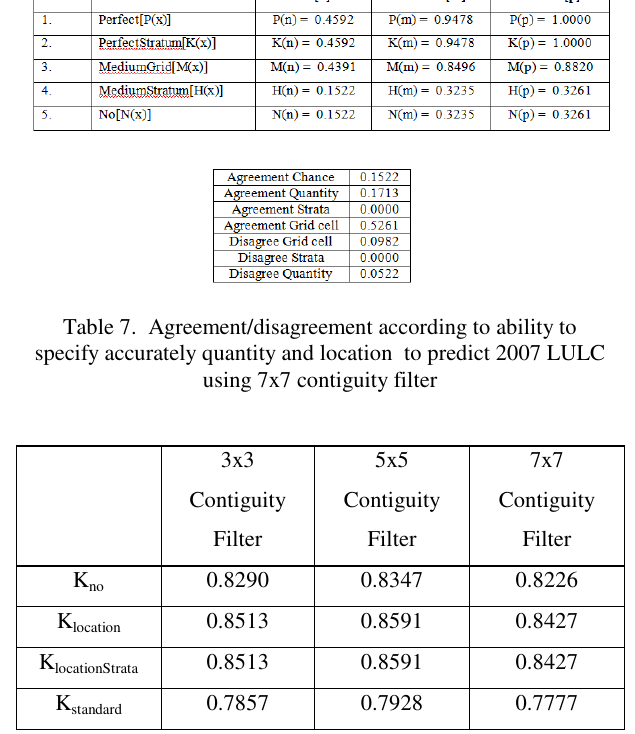
Table 8. Kappa Index of Agreement to ability to